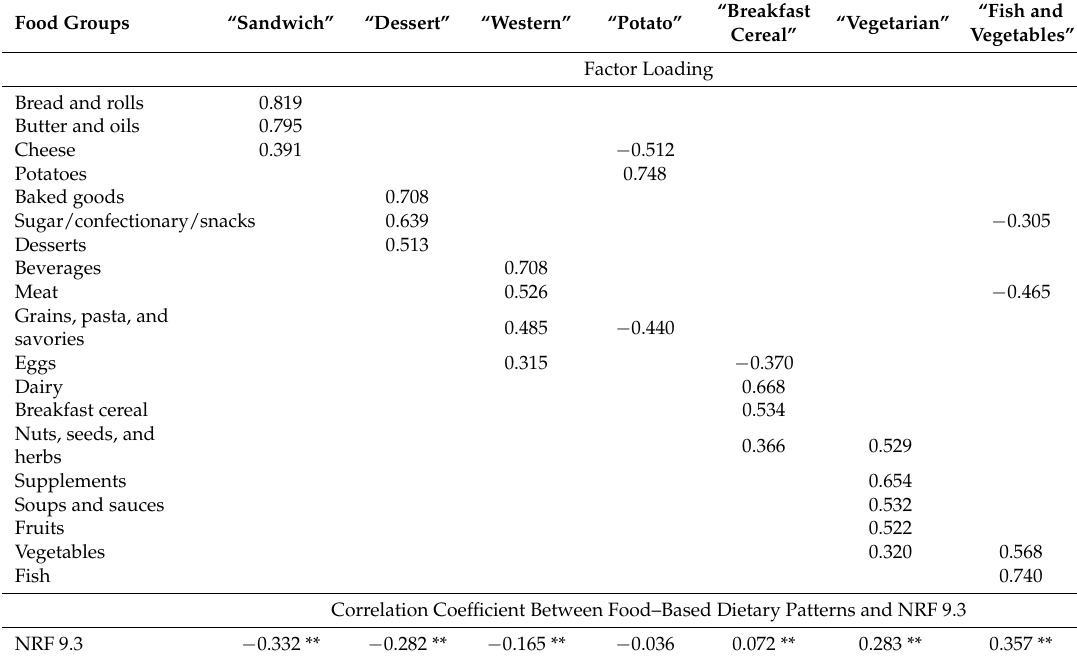
Table 3. A representation* of the main food items that characterized each dietary pattern and its correlation with nutritional index NRF